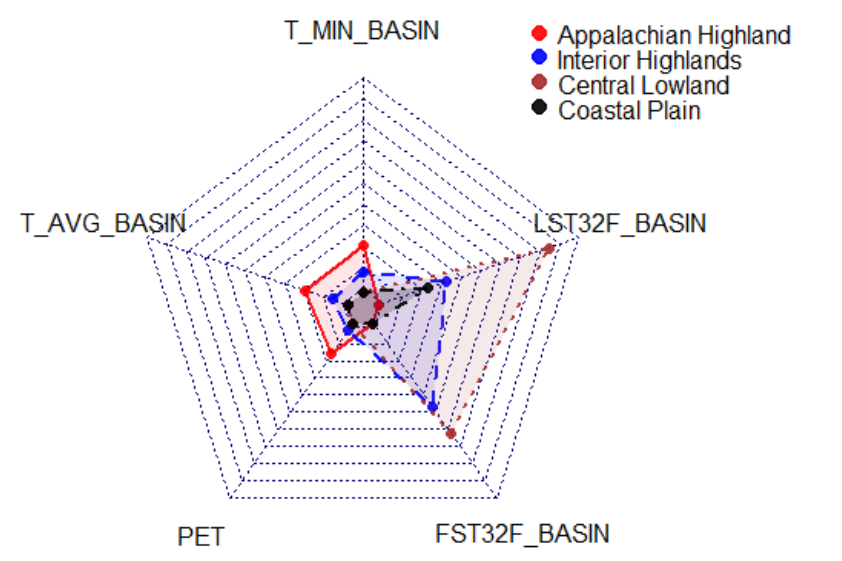
Figure 9. Comparison of importance levels for climate variables (ranking 1 to 10) common to more than one region.